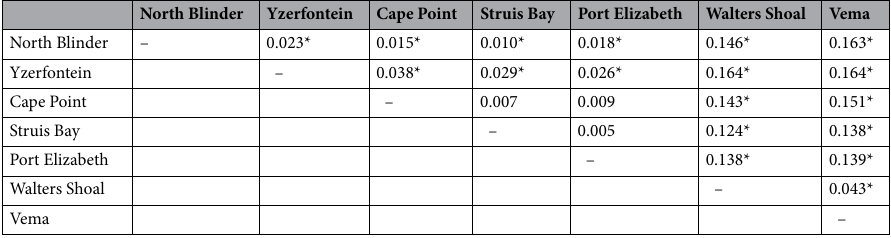
Table 1. Pairwise F ST (1,000 permutations; above diagonal) values of seven Seriola lalandi populations. *Significant F ST p- values ( p < 0.05) after Bonferroni correction.